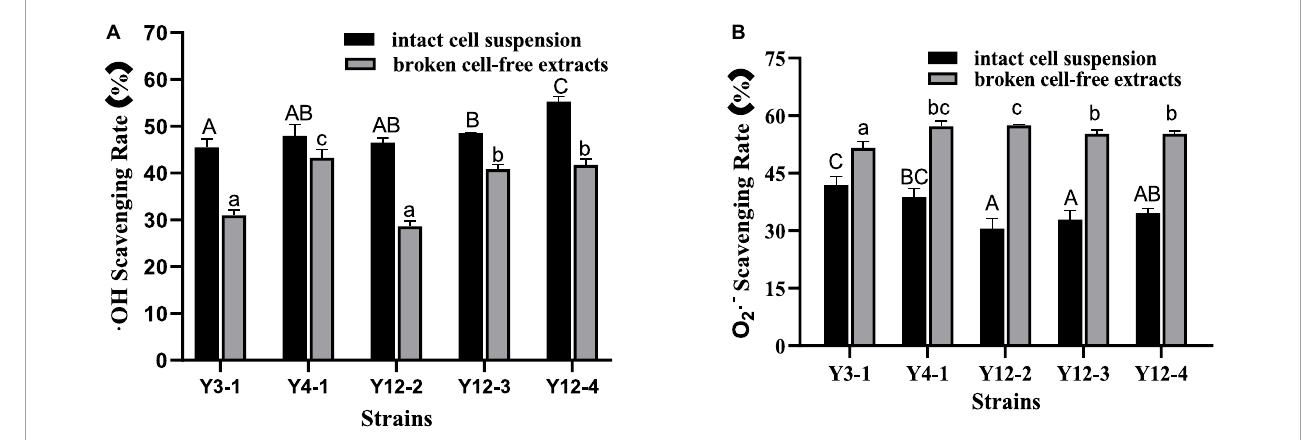
FIGURE2 Free radical scavenging rate of different yeasts. (A) • OH Scavenging Rate; (B) O 2 • - Scavenging Rate. Different capital letters indicated that there was significant difference in free radical scavenging rate among different intact cell suspension ( p < 0.05). Different lowercase letters indicated that there was